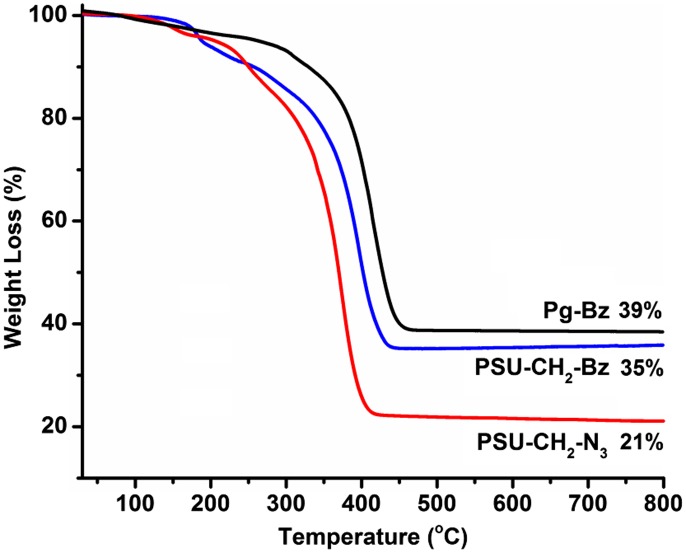
TGA thermograms of Pg-Bz, PSU-CH2-N3 and PSU-CH2-Bz compounds cured at 230 °C for 30 min.